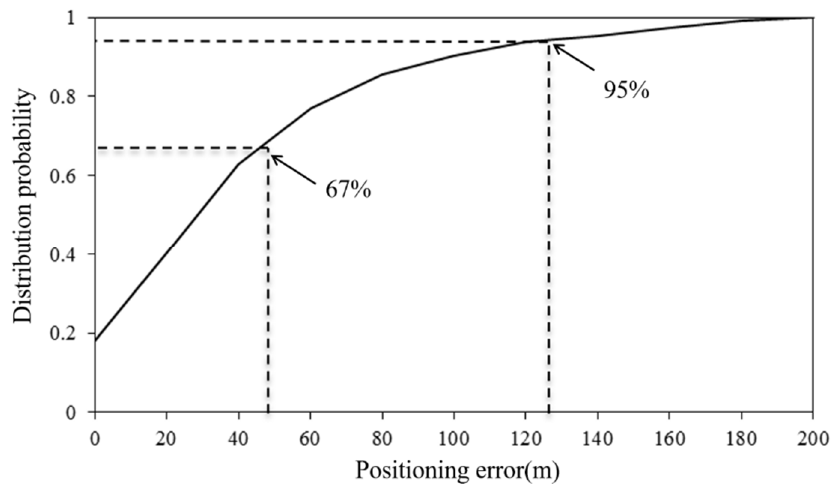
Figure 12. WFC cumulative distribution probability.